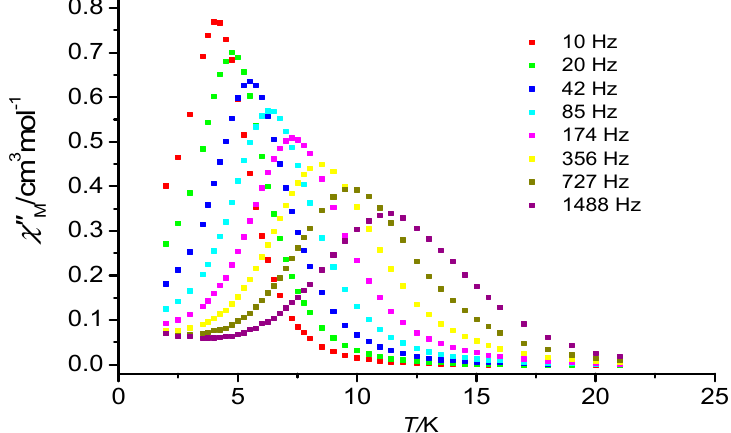
Figure 4. Temperature dependence of χ ‘‘ M for DyH 2 daps in H dc = 1000 Oe at different